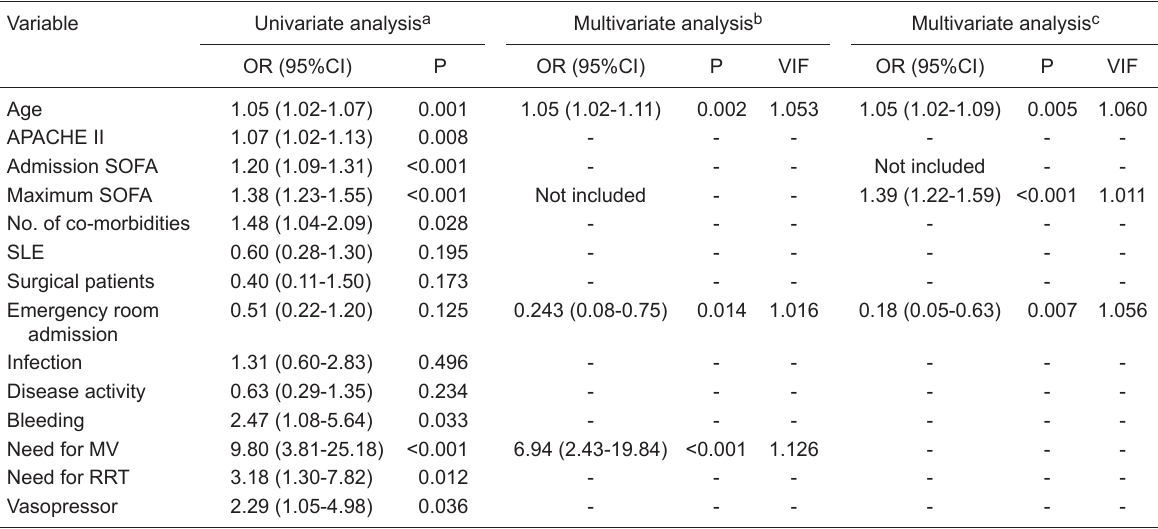
Table 5. Univariate and multivariate analysis of variables associated with the in-hospital mortality of critically ill rheumatologic patients.